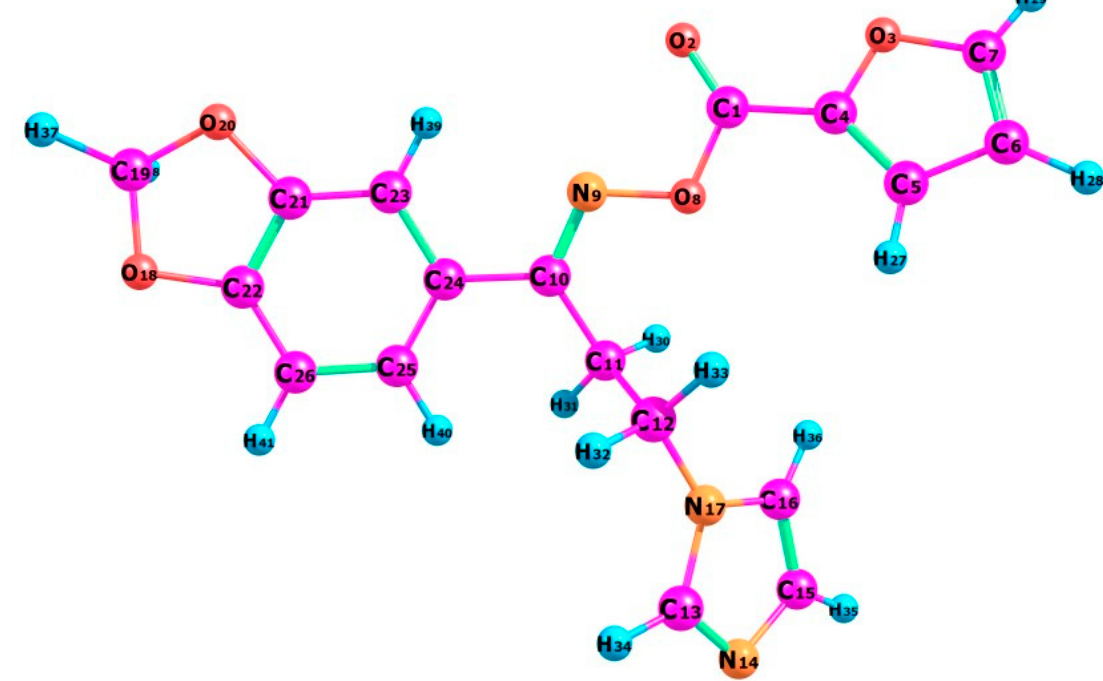
Figure 1. ORTEP diagram of the oximino ester 5 drawn at 40% ellipsoids for non-hydrogen atoms.